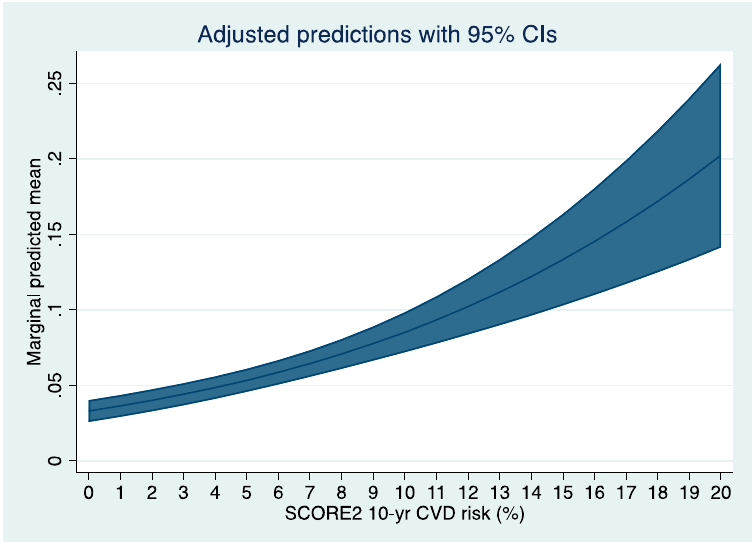
Figure 2. Predicted risk for any advanced colorectal neoplasia based on the SCORE2 obtained by univariable multilevel logistic regression, using the year of inclusion as random effect and the SCORE2 as continuous variable as fixed effect.